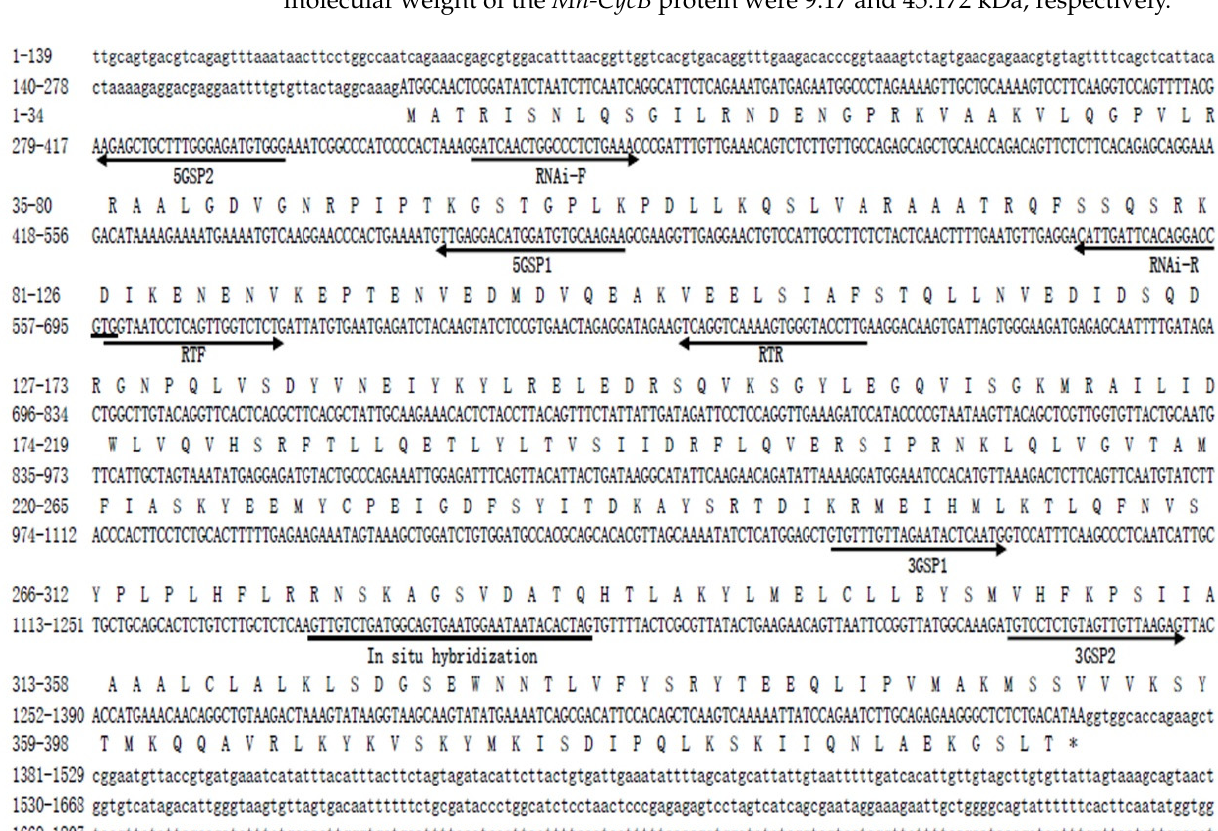
Figure 2. Nucleotide and deduced amino acid sequence of Mn-CycB . The nucleotide sequence is displayed in the 5 ′ –3 ′ direction and is numbered on the left. The deduced amino acid sequence is shown as a single capital letter amino acid code. The 3 ʹ and 5 ʹ untranslated regions are shown with lowercase letters. Codons are numbered on the left, the methionine (ATG) initiation codon is shown, and an asterisk denotes the termination codon (TGA). Arrows and line indicated the direction of location of each primer.